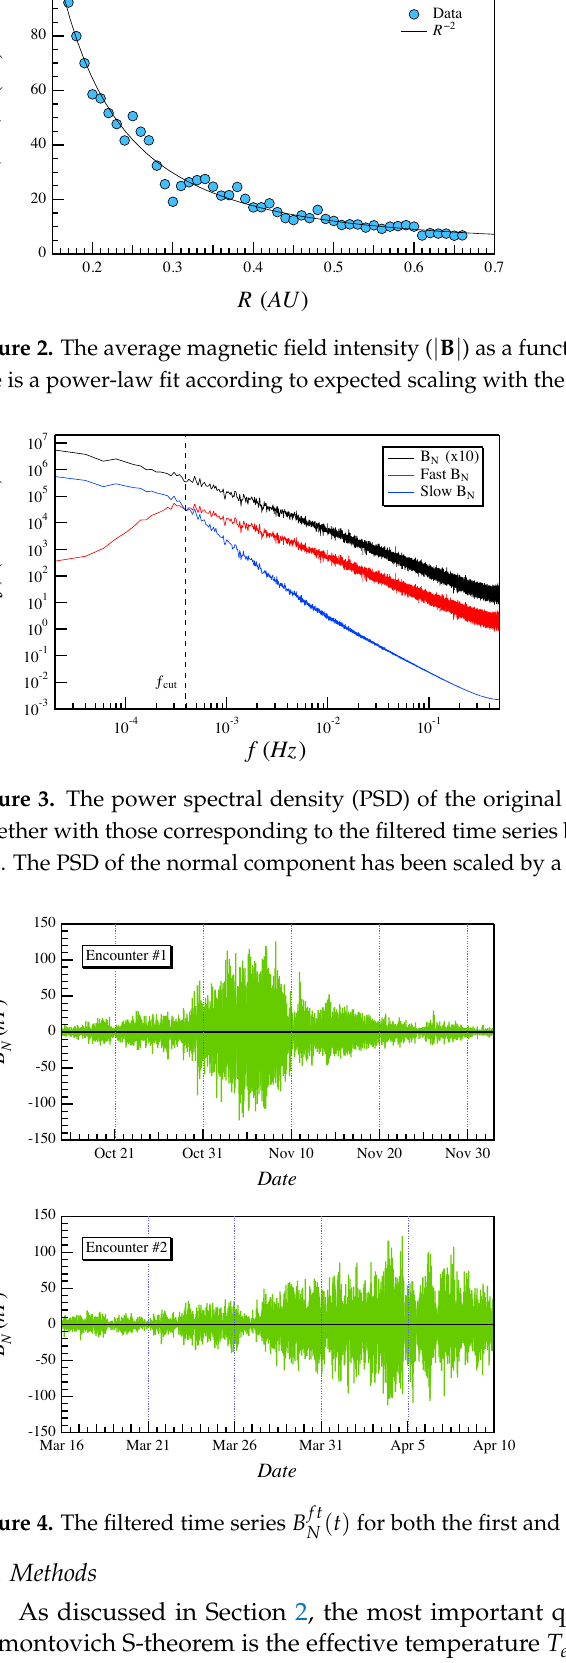
Figure 4. The filtered time series B ft